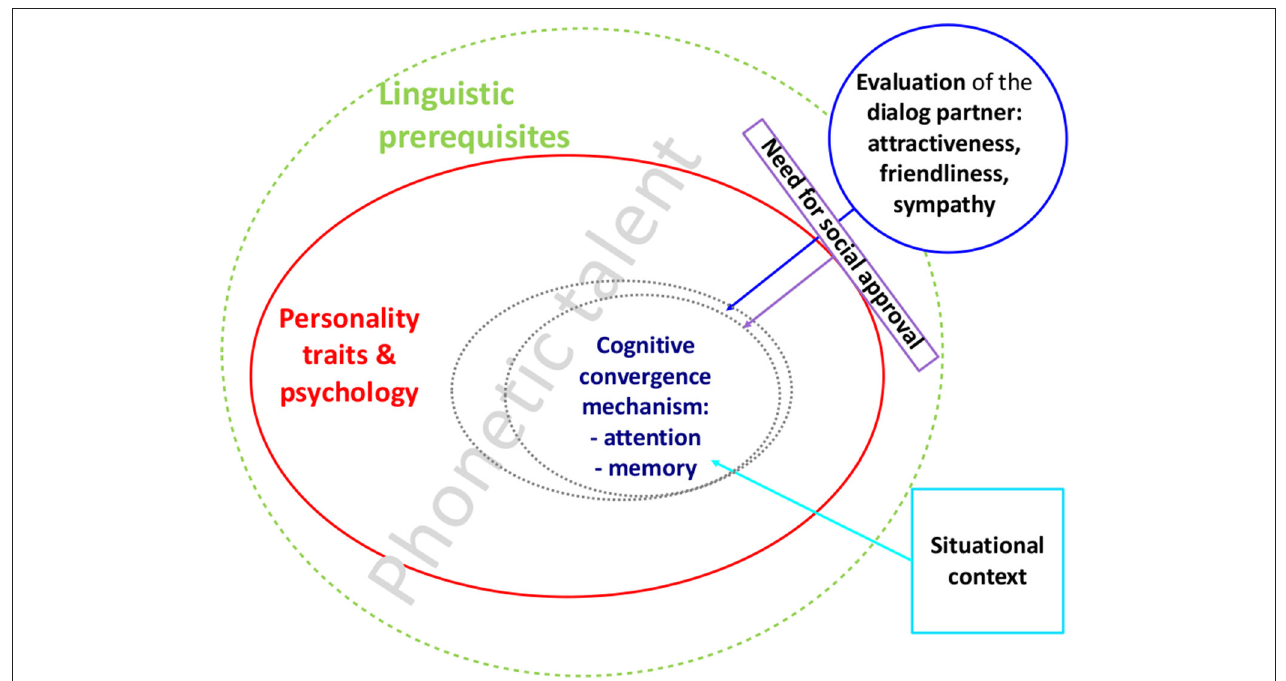
FIGURE 1 | A comprehensive model proposal for phonetic convergence, modified from Lewandowski